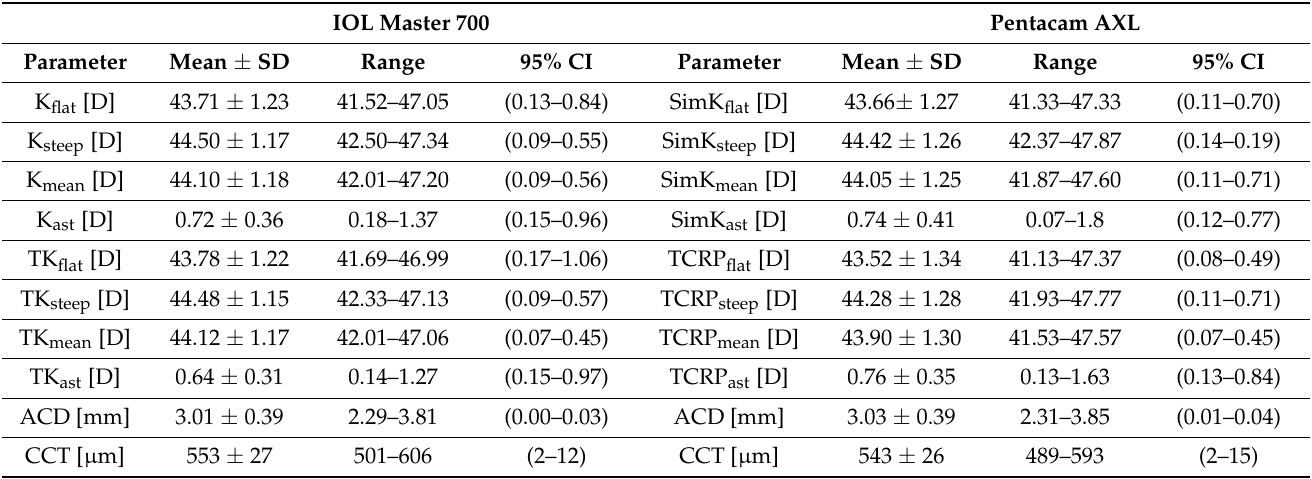
Table 1. Corresponding variables measured with two devices.